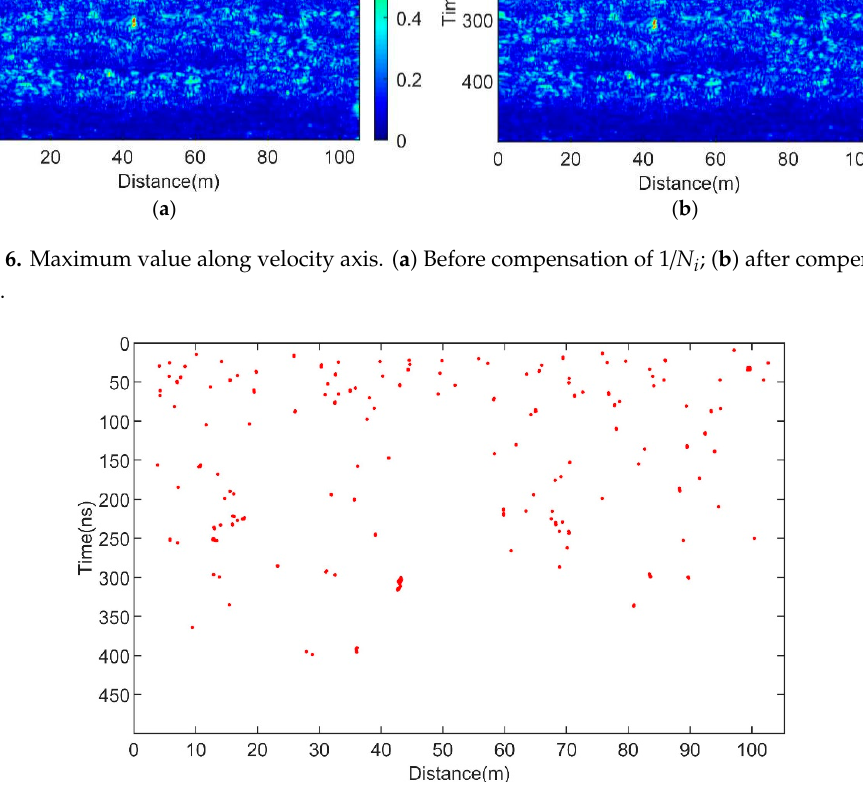
Figure 7. Initial positioning of hyperbolas based on soft threshold.